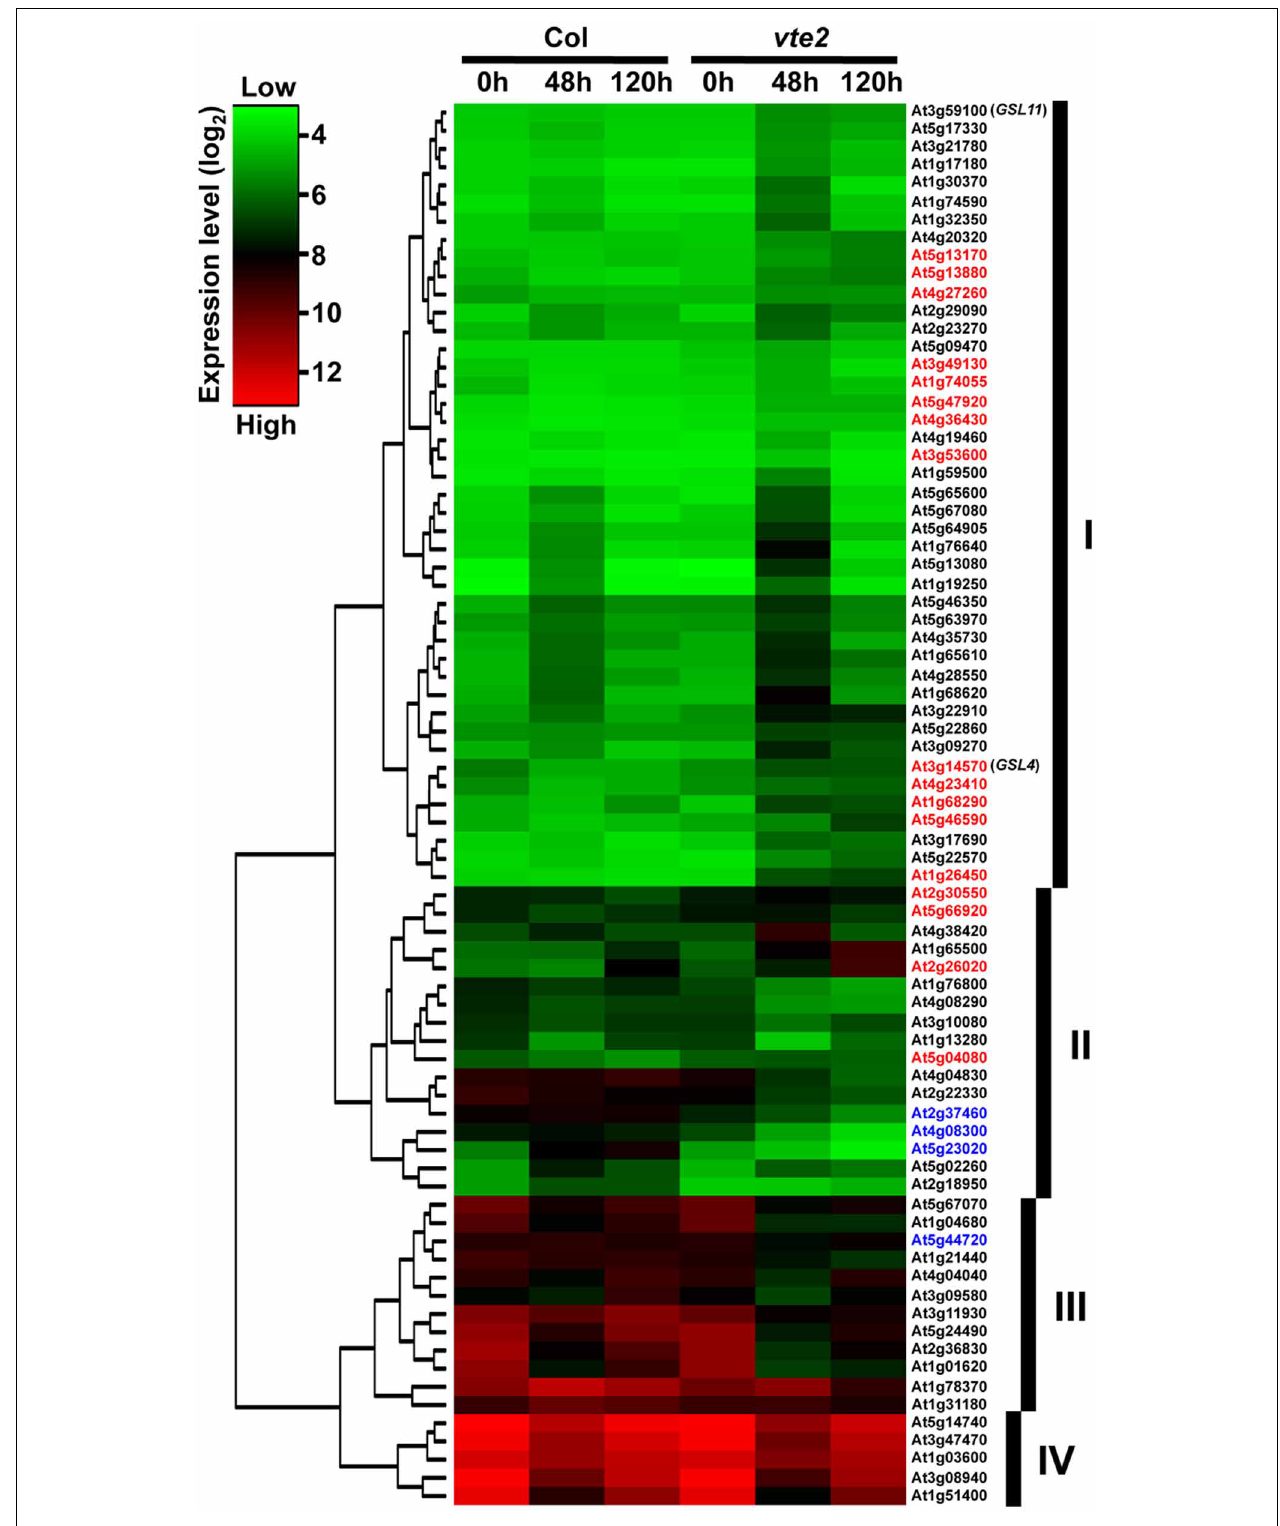
FIGURE 2 | A gene tree of the 77 genes significantly altered in 48 h-LT-treated vte2 relative to Col (adjusted p -value < 0.05). The color bar represents expression levels (log 2 ), with green to red being low to high expression. The groups (labeled as I, II, III, and IV) were based on general